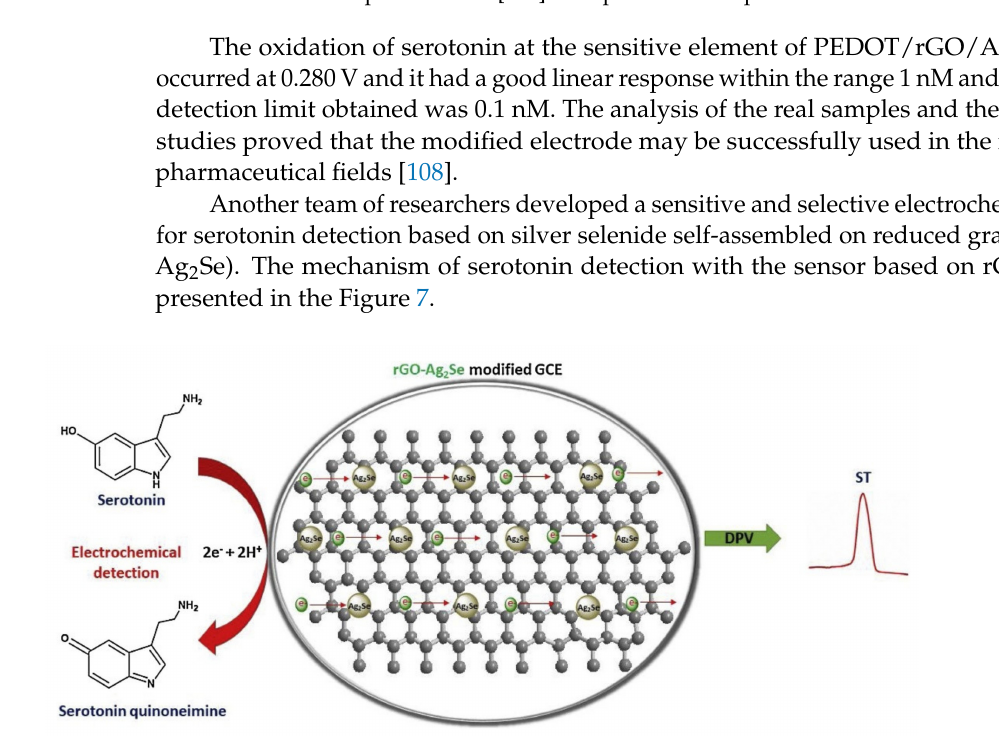
Figure 6. ( a ) Differential pulse voltammograms of the poly(3,4-ethylenedioxythiophene) (PEDOT)/reduced graphene oxide (rGO)/silver nanoparticles (Ag NPs)/GCE sensor immersed in a solution of serotonin of different concentrations: (I) 0.4 µ M, (II) 0.6 µ M, (III) 0.8 µ M, (IV) 1 µ M, (V) 1.8 µ M, (VI) 2.0 µ M, (VII) 2.4 µ M, (VIII) 3.2 µ M, (IX) 4.0 µ M, (X) 6.0 µ M, (XI) 8.0 µ M, (XII) 10 µ M, (XIII) 15 µ M, (XIV) 25 µ M, (XV) 29 µ M, (XVI) 35 µ M, (XVII) 44 µ M. The electrolyte was phosphate buffer solution (PBS) of pH 7.4. The inset figure shows the electrochemical oxidation of serotonin. ( b ) Linear relationship between the peak current and serotonin concentration. Reprinted from [108] with permission of publisher.